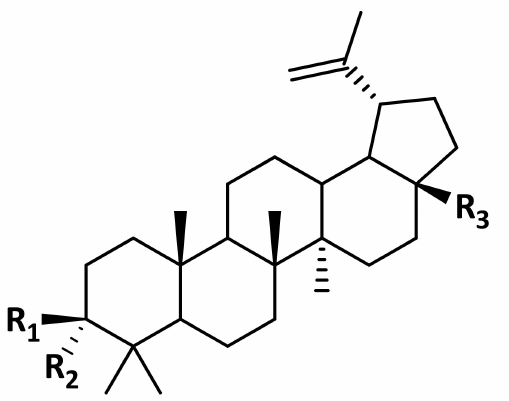
Chart 1. Chemical structure of betulin (R 1 = OH, R 2 = H, R 3 = CH 2 OH), betulonic (R 1 + R 2 = O, R 3 = COOH), and betulonic (R 1 = OH, R 2 = H, R 3 = COOH)